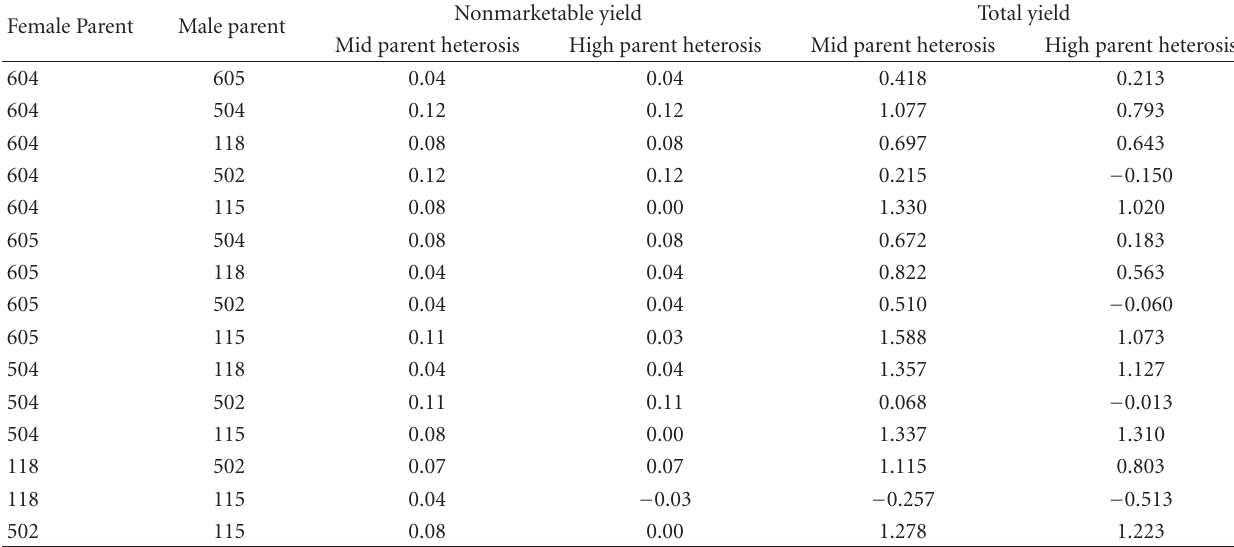
Table 6: High parent heterosis and mid parent heterosis for nonmarketable yield and total